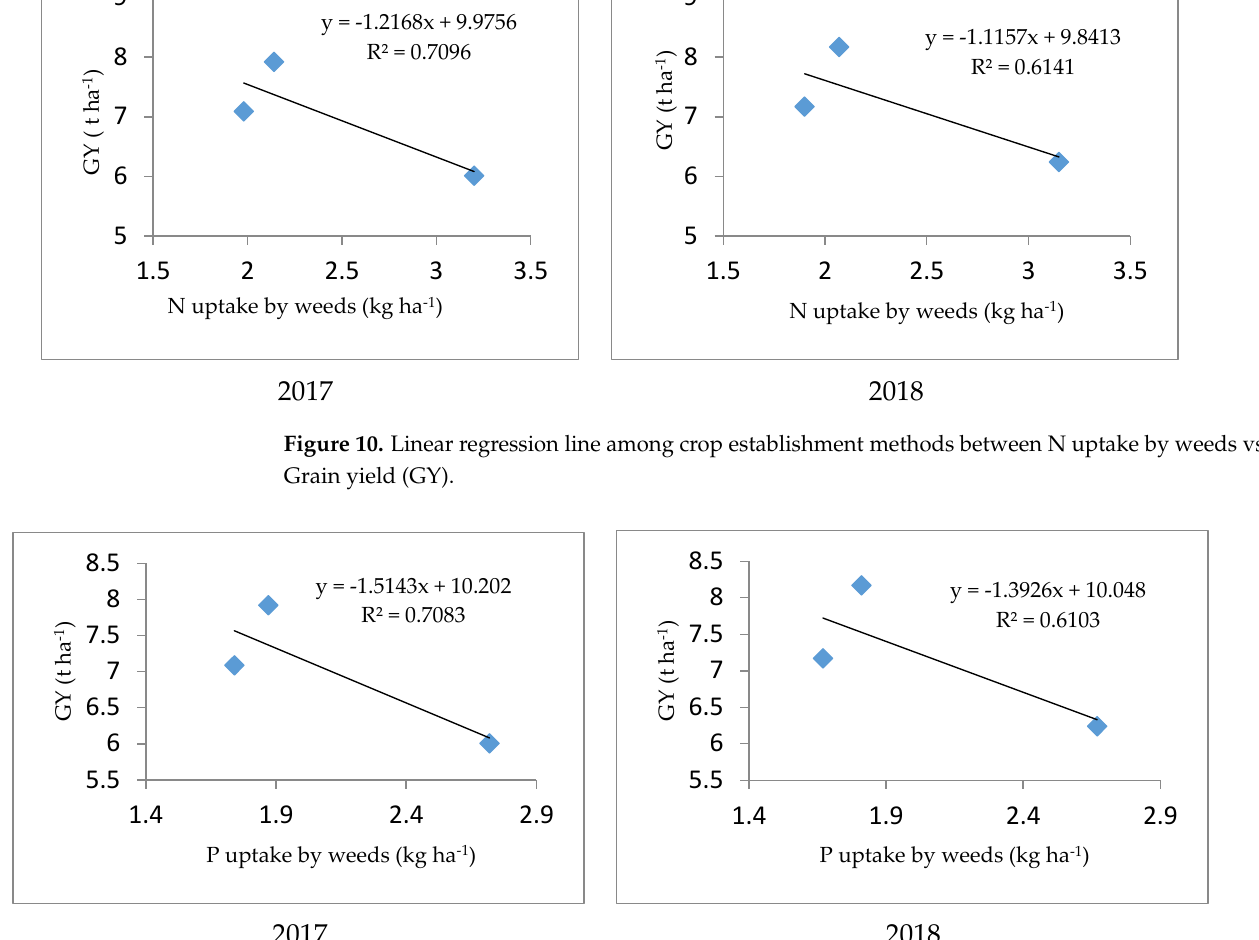
Figure 11. Linear regression line among crop establishment methods between p uptake by weeds vs. Grain yield (GY).